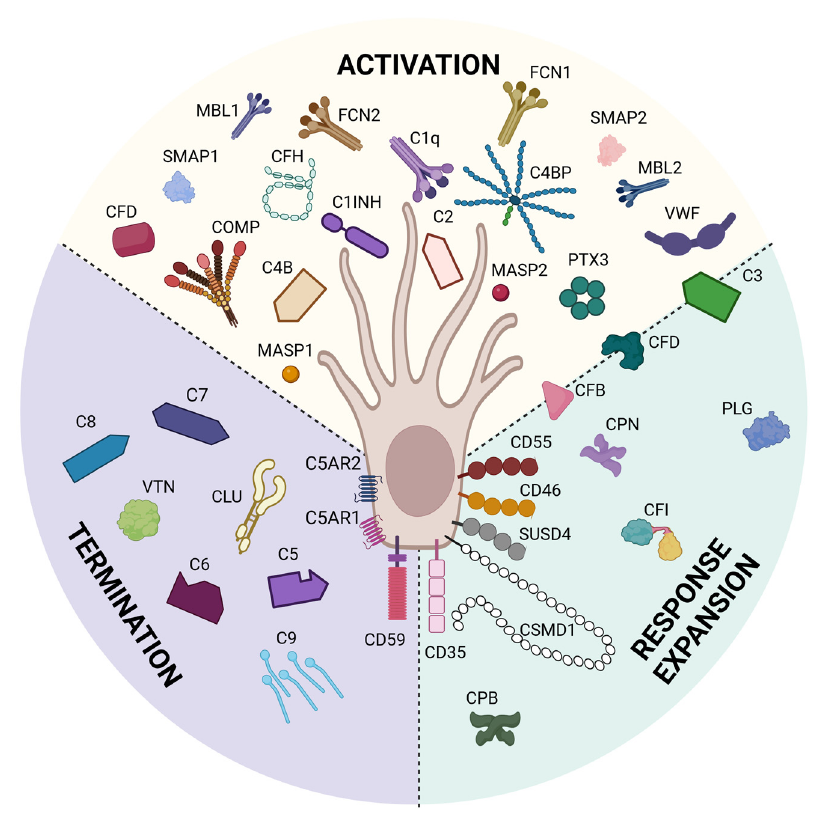
Figure 4. Sertoli cells express complement proteins. Bioinformatic analyses have identified 21 com- plement inhibitors, 25 complement factors, and 3 complement receptors expressed by Sertoli cells. These inhibitors block complement throughout the whole cascade from activation (yellow), response expansion (green), and termination (purple). This figure was created with BioRender, accessed on 1 December 2022.